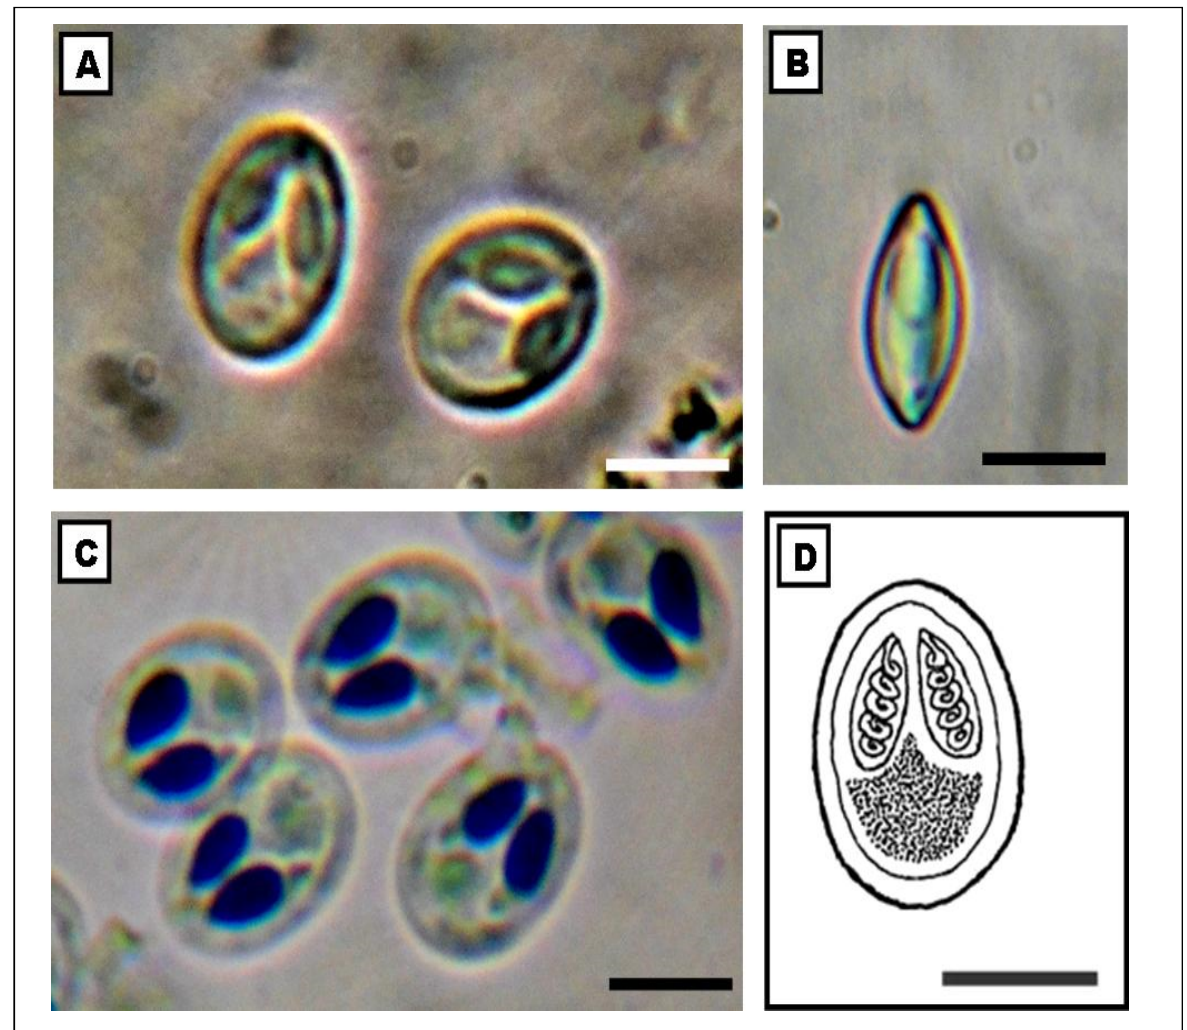
Figure 2: Microphotographs of Myxobolus kodjii sp. nov. (A-C): unstained spores in frontal view (A); unstained spore in lateral view (B); stained spores with May-Grünwald-Giemsa (C). Line drawing of the mature spore (D). Scale bar: 5 µ